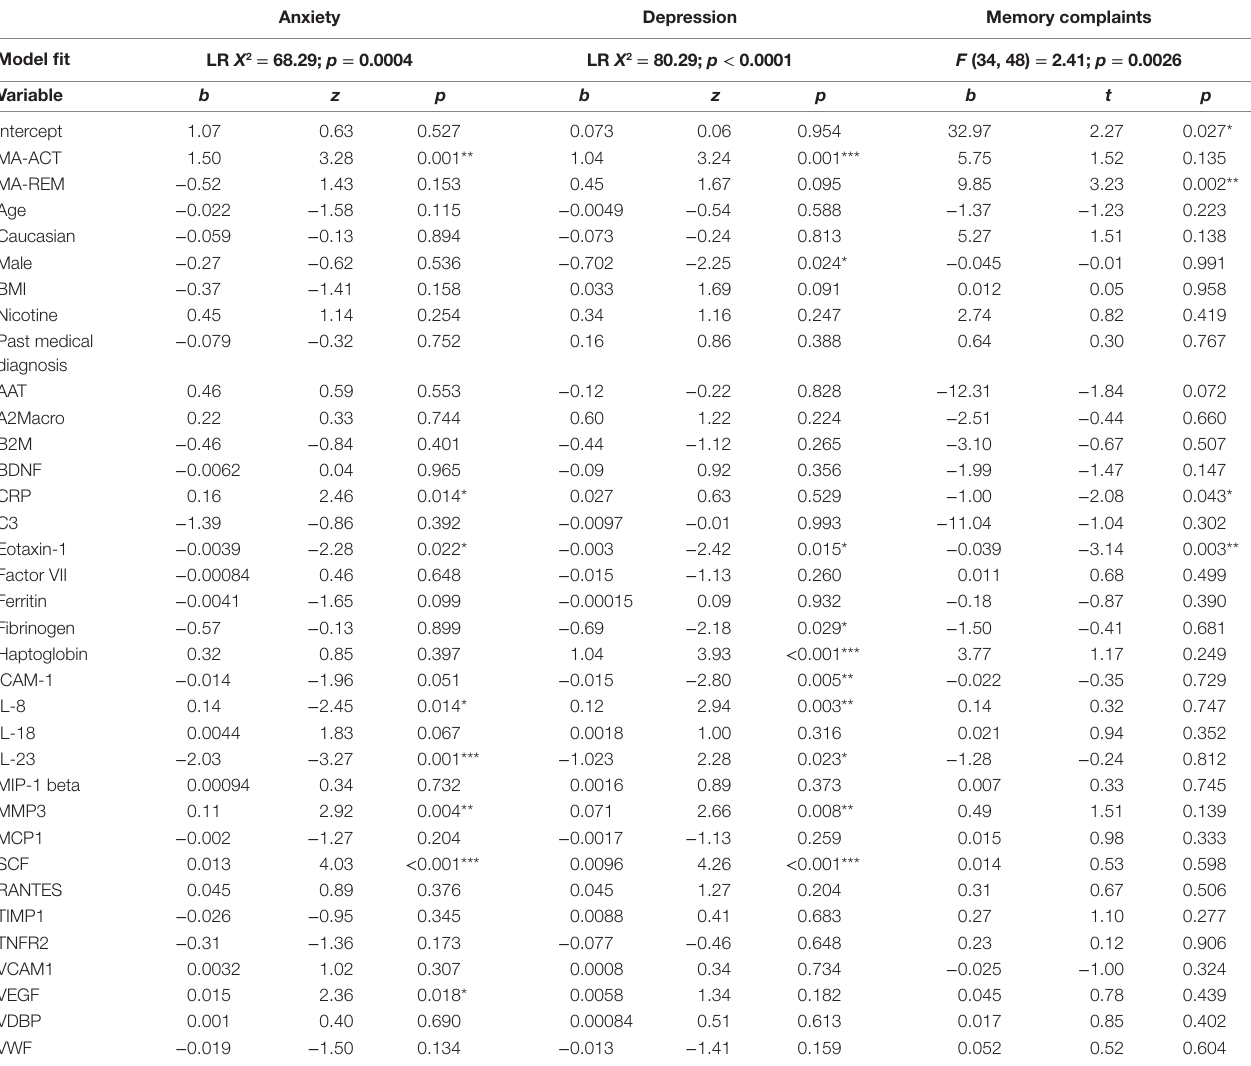
TaBle 3 | Multi-analyte regression models a